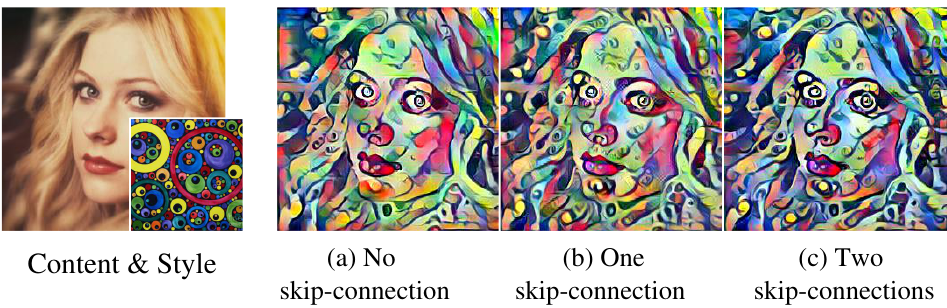
Figure 11. Output stylized images according to the number of